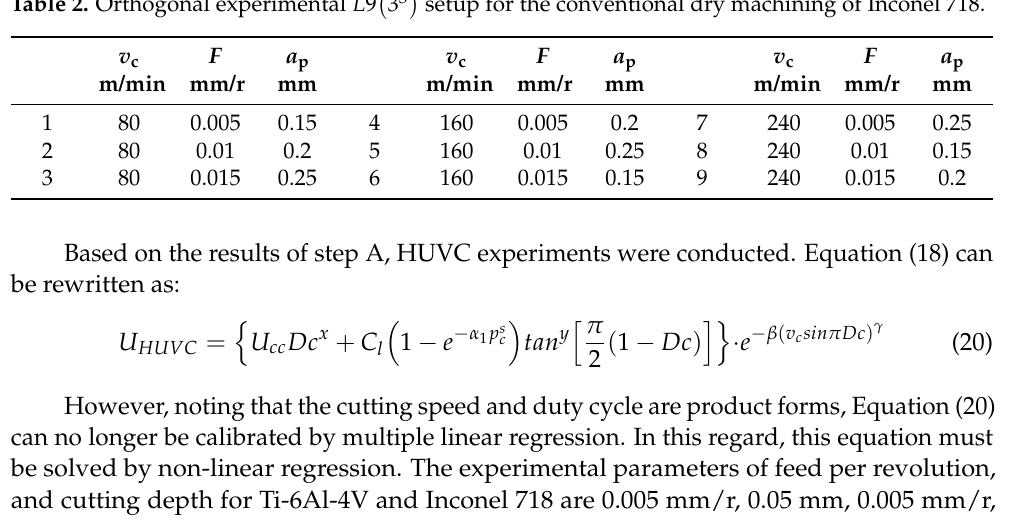
(cid:0) (cid:1) 3 3 setup for the conventional dry machining of Inconel 718.